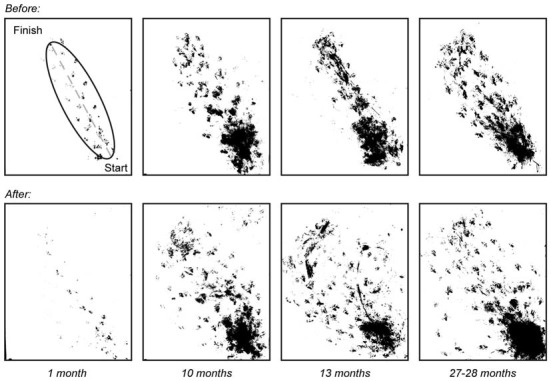
Walking trajectory before and after vestibular stimulus. Photos of walking patterns obtained for mice of ages 1 (n = 3), 10 (n = 7), 13 (n = 6) and 27–28 (n = 8) months were overlaid before and after the vestibular stimulus. An ellipse was fitted to the walking paths of each mouse and the length of the minor axis was measured and used to quantify changes in walking trajectory with age.